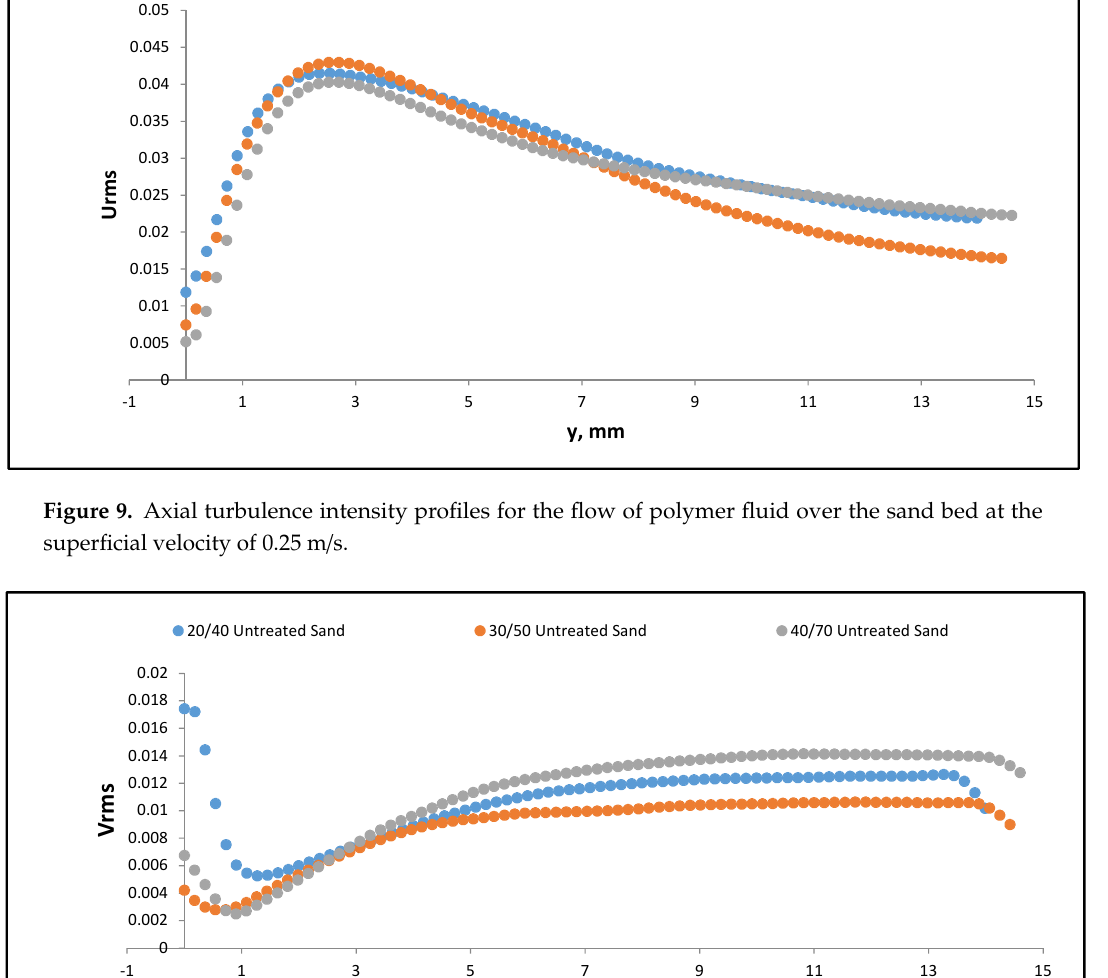
Figure 9. Axial turbulence intensity profiles for the flow of polymer fluid over the sand bed at the superficial velocity of 0.25 m/s.